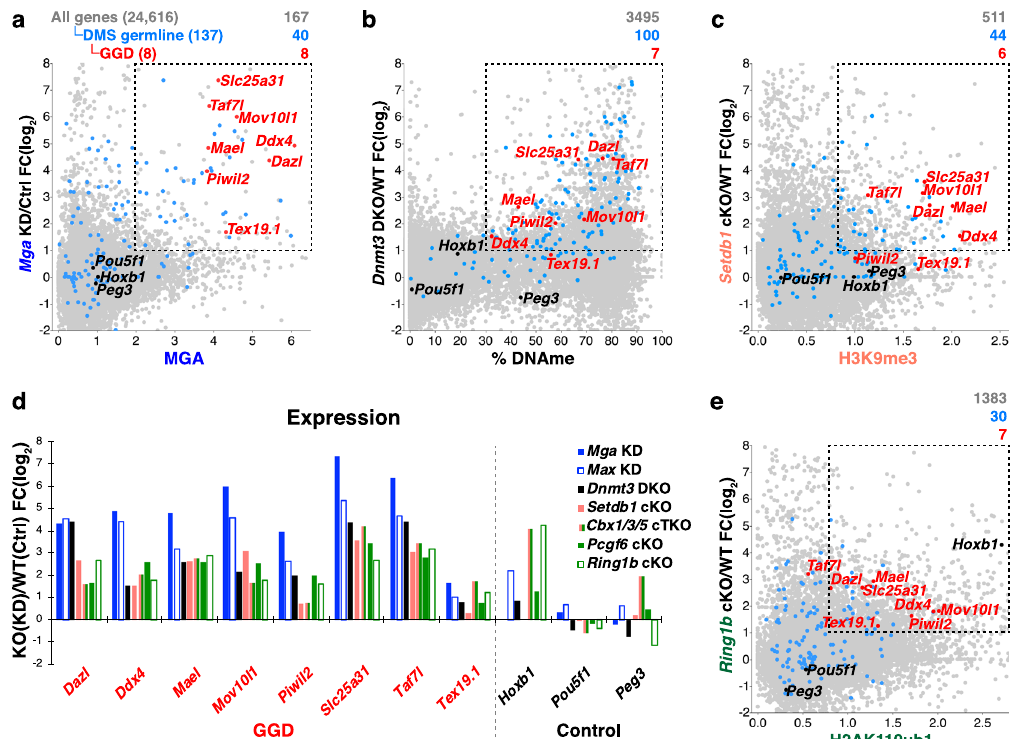
Fig. 2 Depletion of key repressive complex subunits impacts expression of DMS germline genes in pESCs. a – c Scatterplots showing the fold-change (FC) of gene expression in knock-out (KO) or knock-down (KD) vs WT/control (Ctrl) pESCs ( y -axis) for: a Mga KD versus MGA enrichment (RPKM, TSS ±2 kb), b Dnmt3a/3b Double KO ( Dnmt3 DKO) vs % DNAme (TSS − 0.9/ + 0.4 kb), c Setdb1 conditional KO (cKO) vs H3K9me3 enrichment (TSS ±2 kb). For ( a – c ), ChIP-seq data are presented as RPKM values. d Bar graph showing the FC of gene expression in repressor complex subunit KO/KD pESCs relative to WT/Ctrl at GGD and control genes. e Scatterplot showing the FC of gene expression in Ring1b cKO vs H2AK119ub1 enrichment (RPKM, TSS ±2 kb). The total number of genes in each category (in parentheses), as well as the number of genes showing a >2-fold increase in expression and MGA enrichment (RPKM > 2), DNAme level >30%, H3K9me3 enrichment (RPKM > 0.8), and H2AK119ub1 enrichment (RPKM > 0.8), respectively, is shown at the top of each plot. All, DMS germline and GGD genes are color-coded as in panel ( a